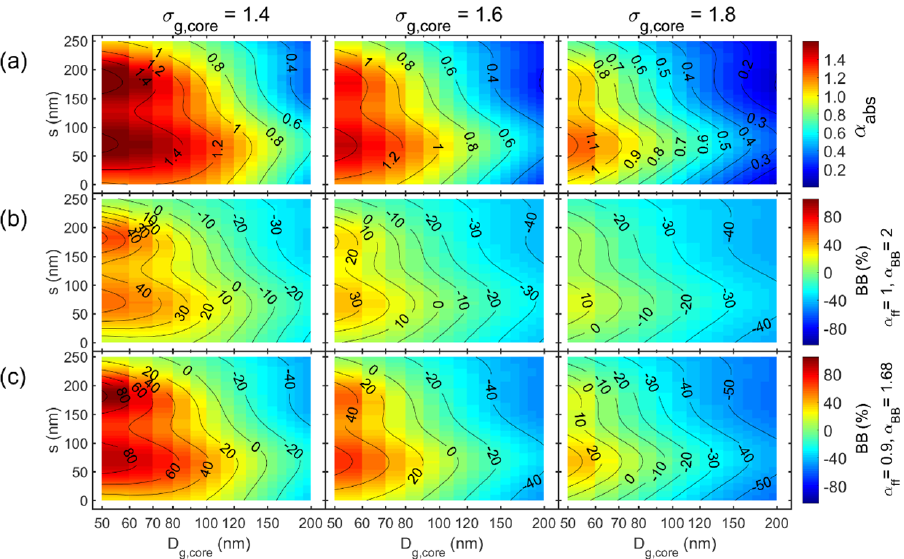
Figure 3. Unimodal particle size distributions with a size-independent shell thickness ( s ) for three widths of the core size distributions: σ g , core = 1.4, 1.6, and 1.8. (a) Absorption Ångström exponent ( α abs ) and the fraction of biomass-burning BC (BB(%)) calculated from it with the Aethalometer model constants of (b) α ff = 1 and α bb = 2 and (c) α ff = 0.9 and α bb = 1.68 vs. the geometric mean diameter of the core ( D g , core